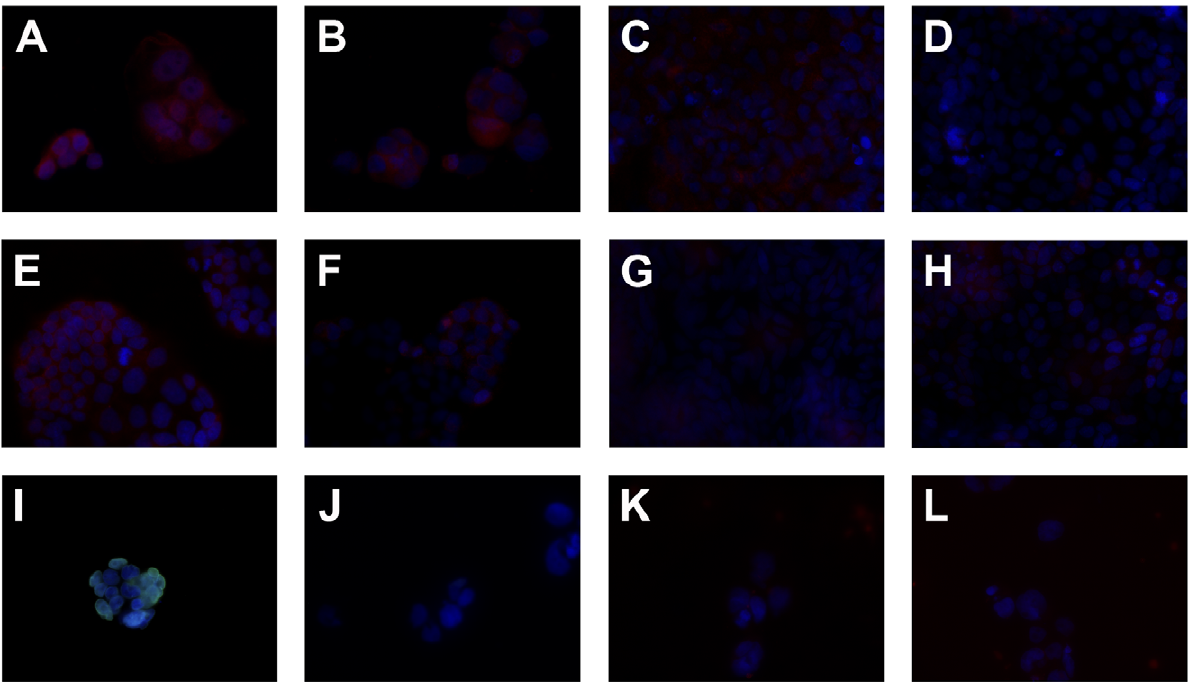
Figure 6. Abundant surface and cytoplasmatic Fc e RI a -chain expression only in subconfluent human intestinal tumor cell lines. Immunofluoresence staining for (A–H) Fc e RI a is performed in (A, B) subconfluent and (C, D) confluent Caco2/TC7 as well as in (E, F) subconfluent and (G, H) confluent HCT-8. Triton-X-100 permeabilized (A, C, E, G) and untreated cells (B, D, F, H) were compared. (I–L) Representative control staining in subconfluent Caco2/TC7 with the (I, J) anti-lamin A/C or (K, L) unspecific murine IgG2b, (I, K) permeabilized or (J, L) untreated. The blue fluorescence DAPI staining indicates the nuclei. Original magnification 6 40.